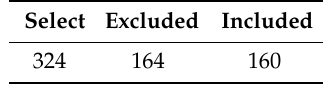
Table 4. Papers concerning empirical research.